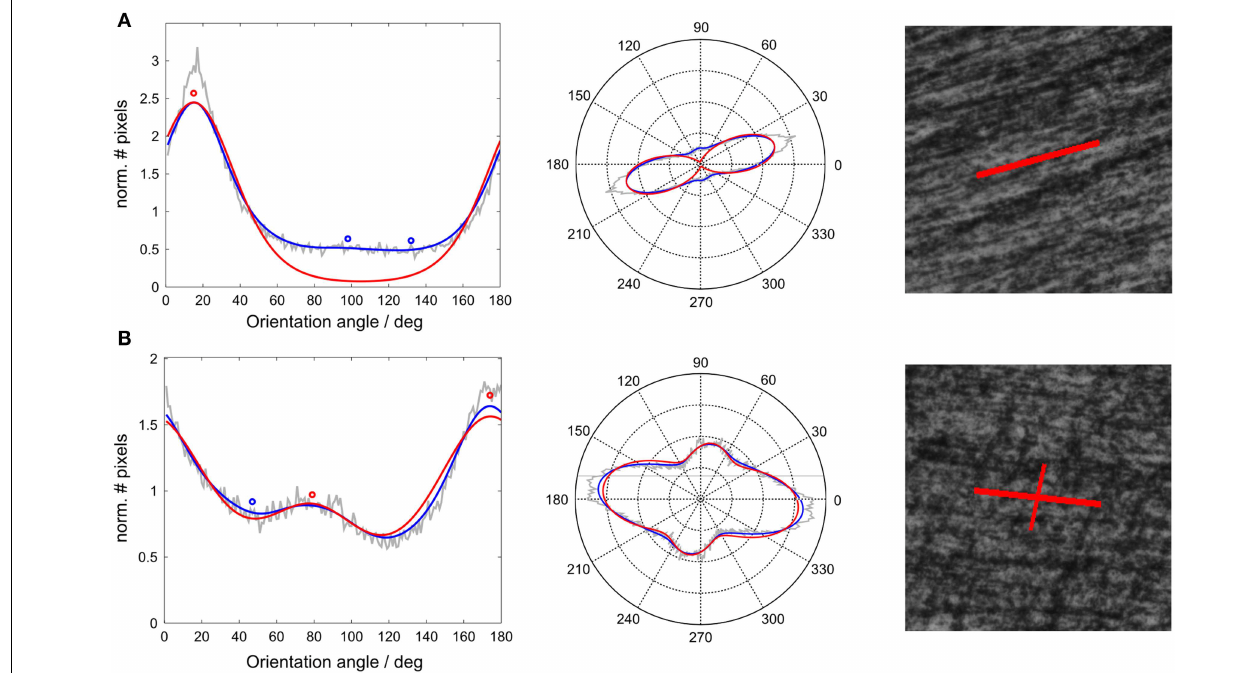
values of the von Mises components were the resulting histological orientations in a voxel (circles). Middle: Same histograms as polar plots. Right: High amplitude voxel orientations (corresponding to red circles) visualized on corresponding histological tile. (A) Example of 1-orientation voxel, (B) 2-orientation